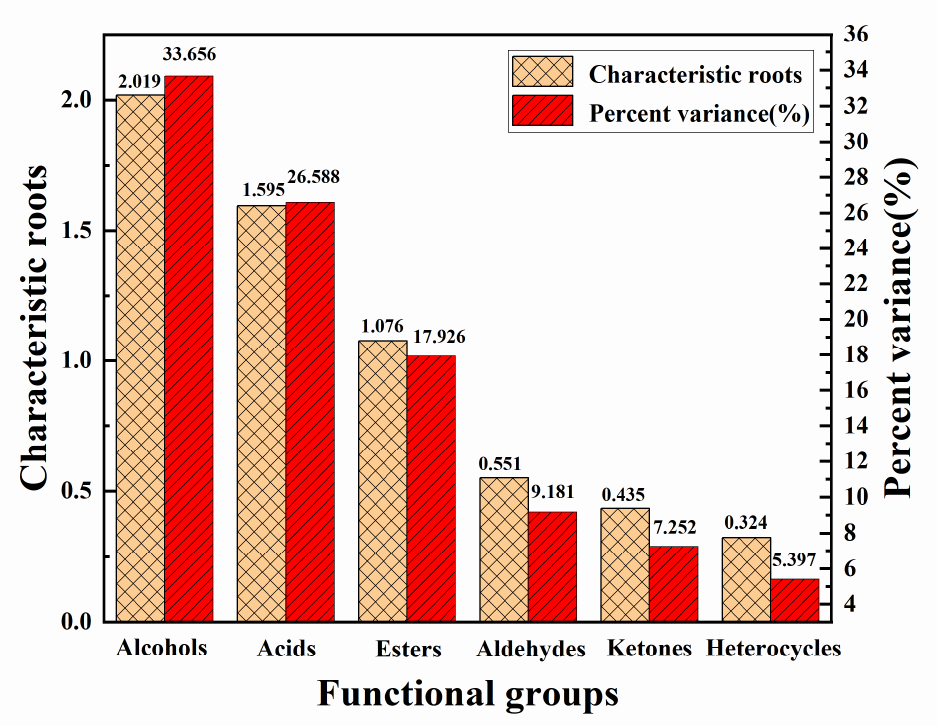
Figure 5. Results of variance analysis of volatile aroma components in ice cream samples.